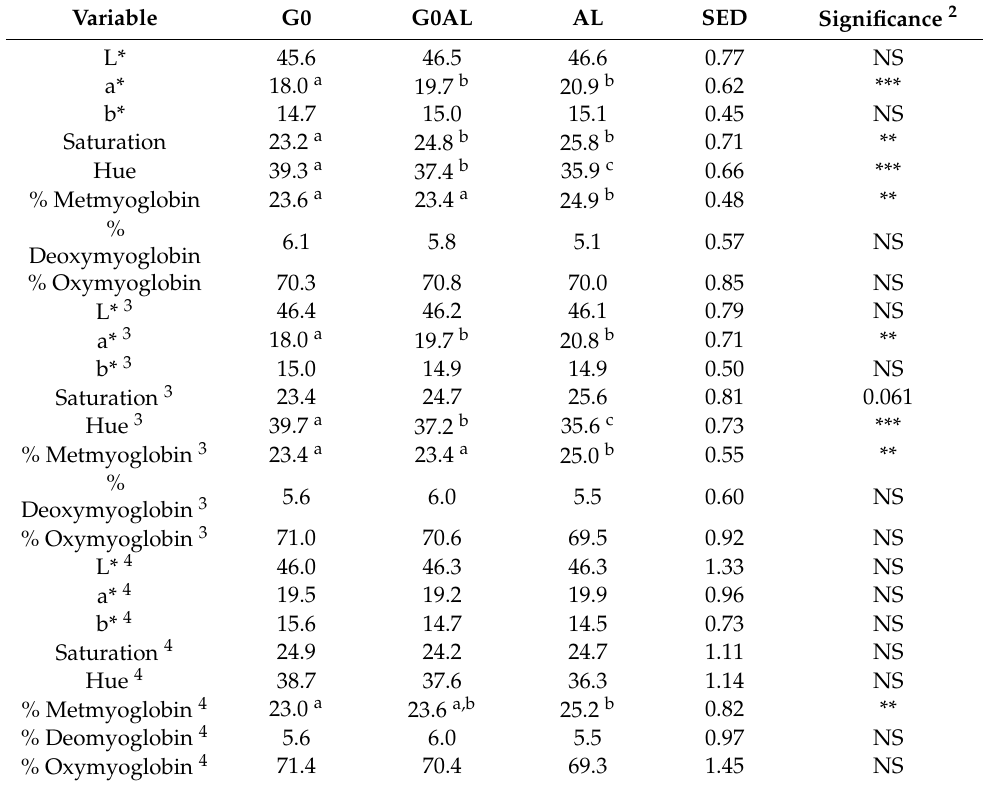
Table 4. Colour 1 after 24-h aerobic display (beginning at 72 h post-mortem) of the longissimus muscle of suckler bulls slaughtered after: 199 days at pasture (GO); 98 days at pasture followed by 101 days indoors and offered concentrates (G0AL); and 199 days indoors and offered concentrates (AL).